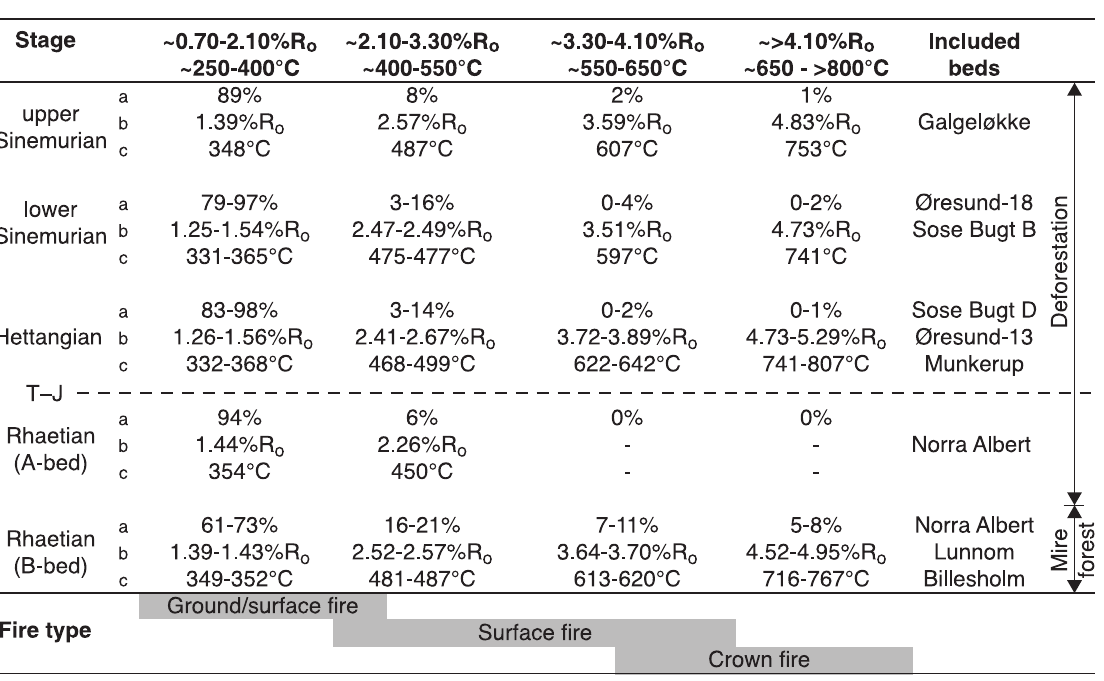
Figure 4. Inertinite reflectance histograms showing calculated burning temperatures of selected reflectance intervals and the possible fire types. A Sample from the Hettangian Munkerup Member (section 2, bed 1, sample 2763/M-3-1.2). Most inertinite has low reflectance suggesting it was primarily derived from surface fire. B Sample from the B-bed in the Rhaetian Bjuv Member (Norra Albert quarry, sample 18812). Almost 25% of the inertinite is high-reflecting suggesting it was derived from high temperatures reached in crown fires.